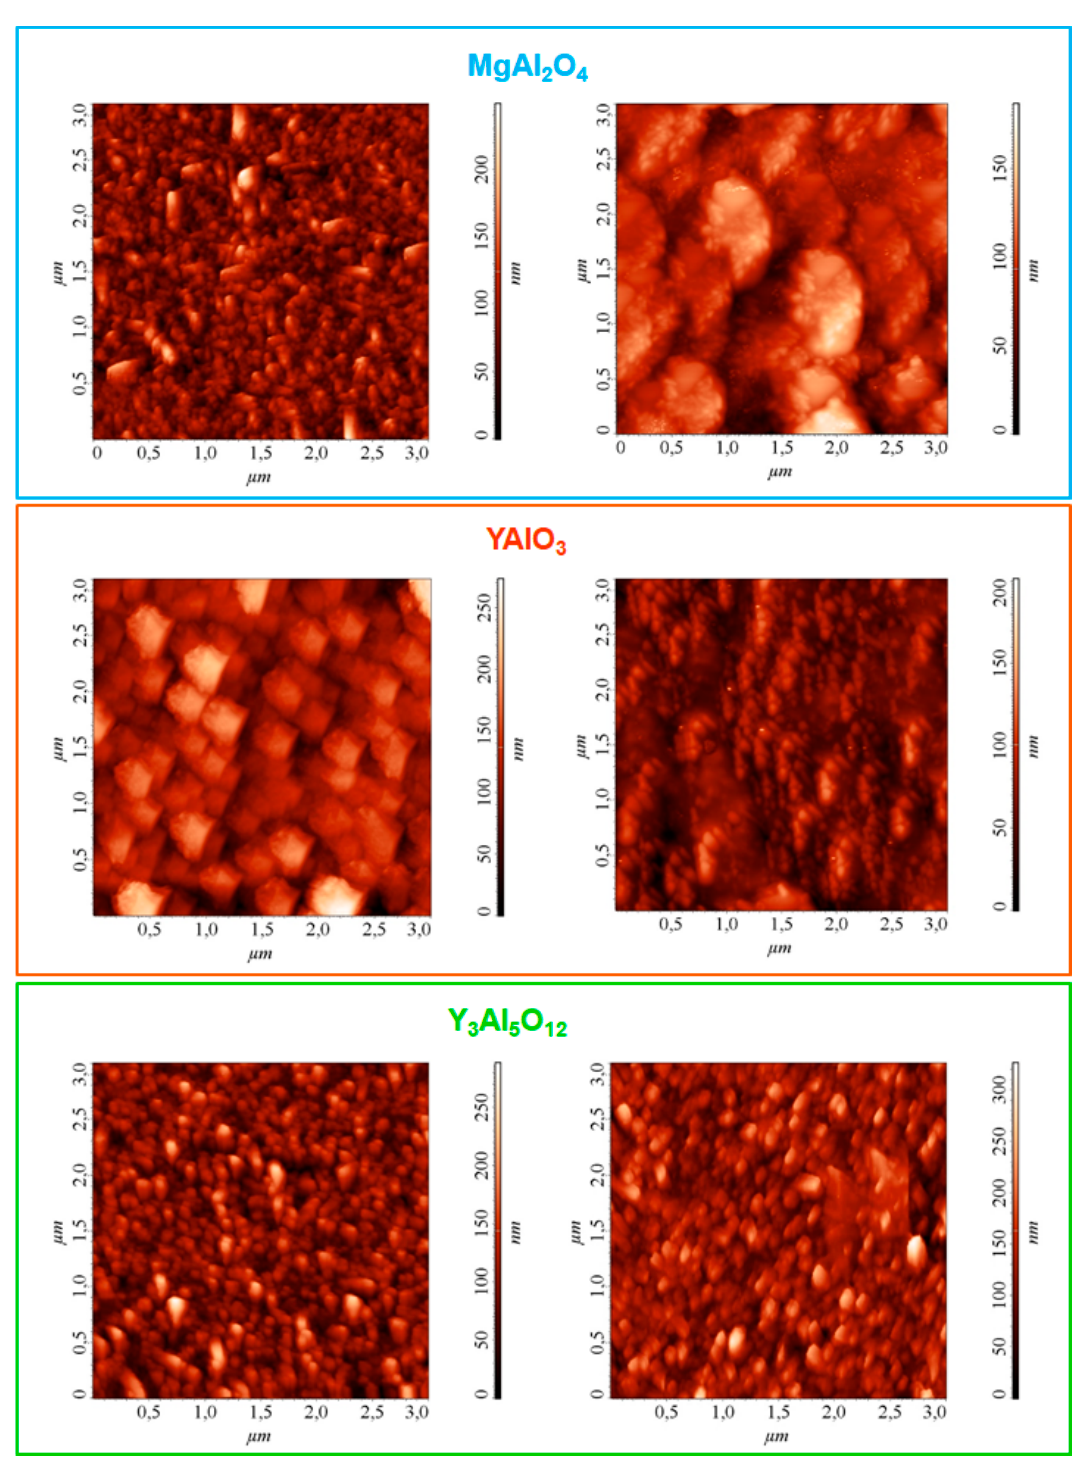
Figure 6. AFM (left) and MFM (right) micrographs for manganese oxide specimens deposited on MgAl 2 O 4 (100), YAlO 3 (010), and Y 3 Al 5 O 12 (100). The corresponding RMS roughness values were 28, 40, and 35 nm, respectively.